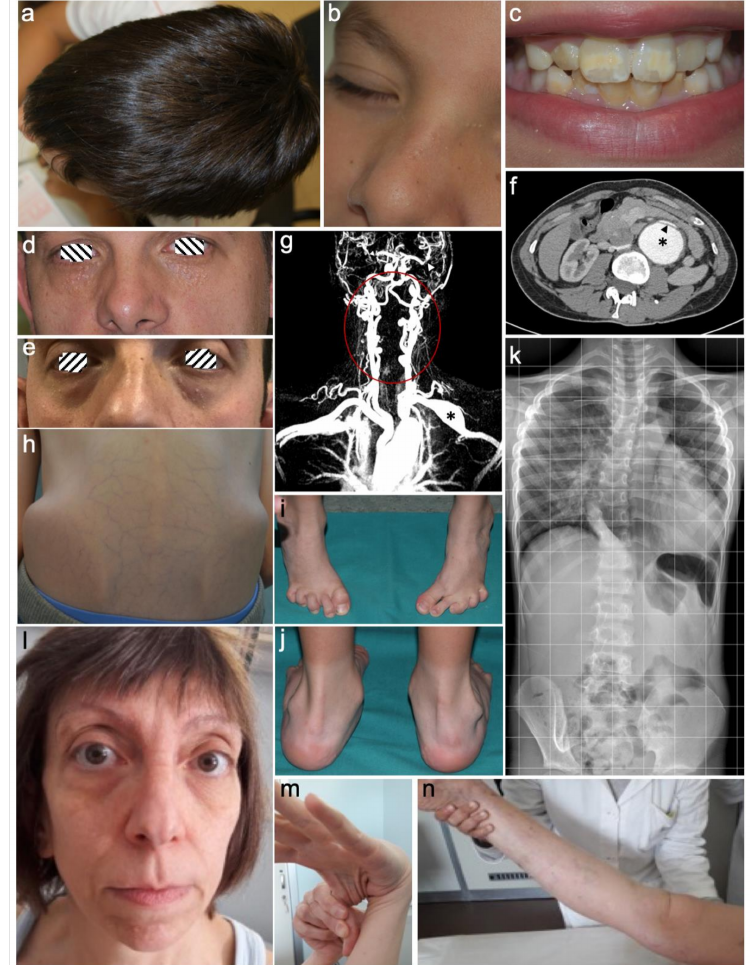
Figure 1. Clinical and instrumental findings observed in our Loeys-Dietz syndrome (LDS)